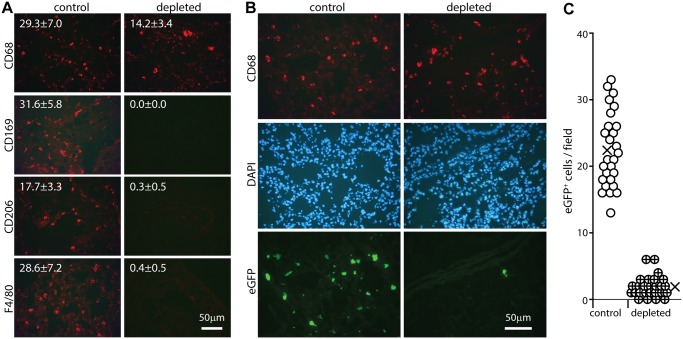
Effect of macrophage depletion on host entry.
A CD169+/DTR mice were given i.p. diphtheria toxin (500ng) or not daily for 2 days, and lung sections stained for macrophage markers. Representative images are shown. Numbers show mean ± SD of cell counts per field of view on 9 sections from 3 mice. The reductions with depletion were all highly significant (p<0.001 by Student’s unpaired 2 tailed t test). B Mice depleted of CD169+ cells as in A were infected i.n. with ORF50-eGFP+ MuHV-4 (105 p.f.u.). After 1 day lung sections were stained for CD68 and analysed for infection by staining for eGFP. Nuclei were stained with DAPI. Representative images are shown. C Quantitation of eGFP numbers from mice treated as in B (3 fields of view per section on 9 sections from 3 mice) showed that toxin treatment reduced significantly lung infection (p<10-5 by Student's 2-tailed unpaired t test). Circles show individual counts, crosses show means.